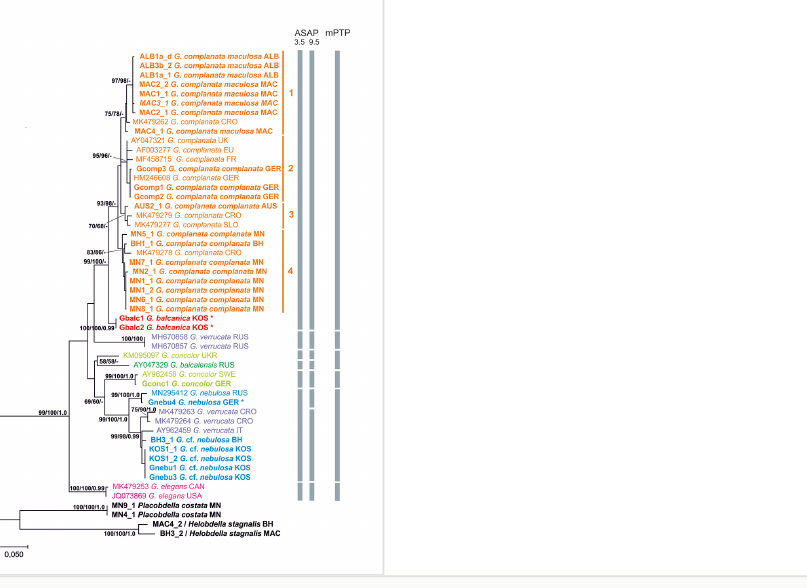
Maximum Likelihood tree of Glossiphoniidae, obtained from 52 nucleotide COI sequences. Bootstrap values > 50% are provided at major nodes for both tree calculation methods